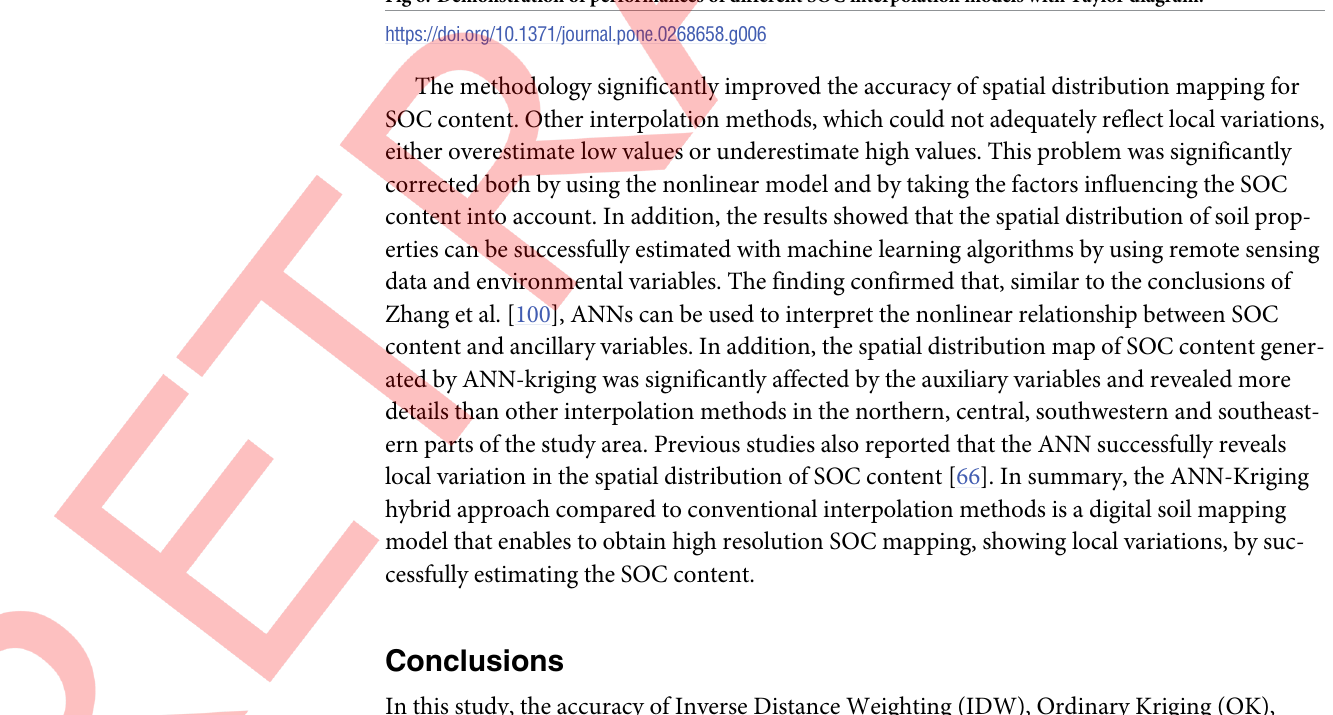
Fig 6. Demonstration of performances of different SOC interpolation models with Taylor